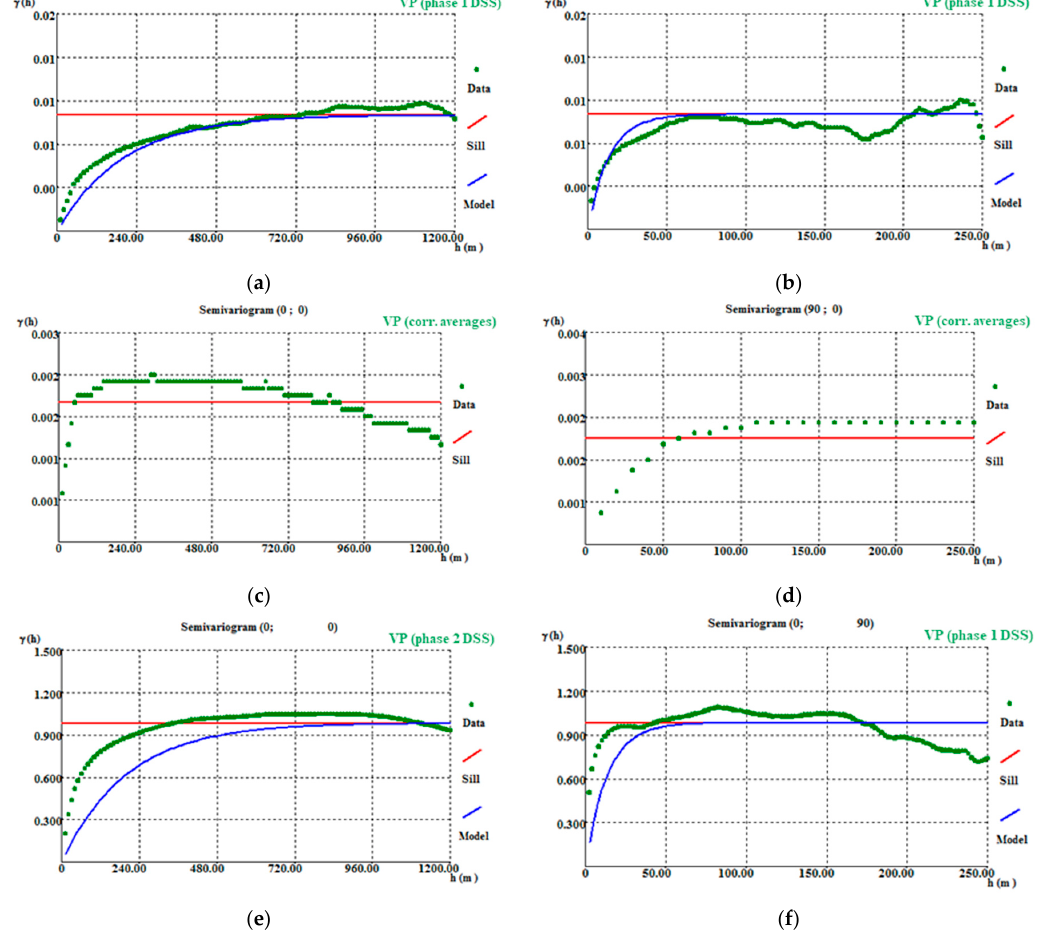
Figure A9. Different phases of variogram adjustment applied to the first simulated scenario: ( a ) DSS phase 1 horizontal variogram; ( b ) DSS phase 1 vertical variogram; ( c ) DSS phase 1 average correction horizontal variogram; ( d ) DSS phase 1 average correction vertical variogram; ( e ) DSS phase 2 horizontal variogram; ( f ) DSS phase 2 vertical variogram.